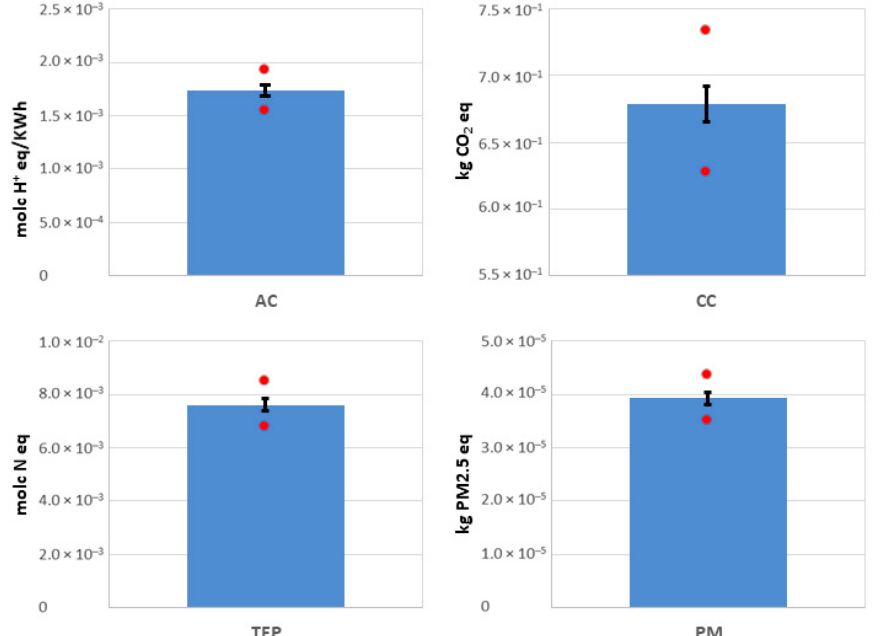
Figure 5. Characterized impact results per kWh of electricity produced for the categories CC, TE, AC and PM. Bars represent the standard deviation around the average impact values, whereas red dots refer to MIN and MAX values.